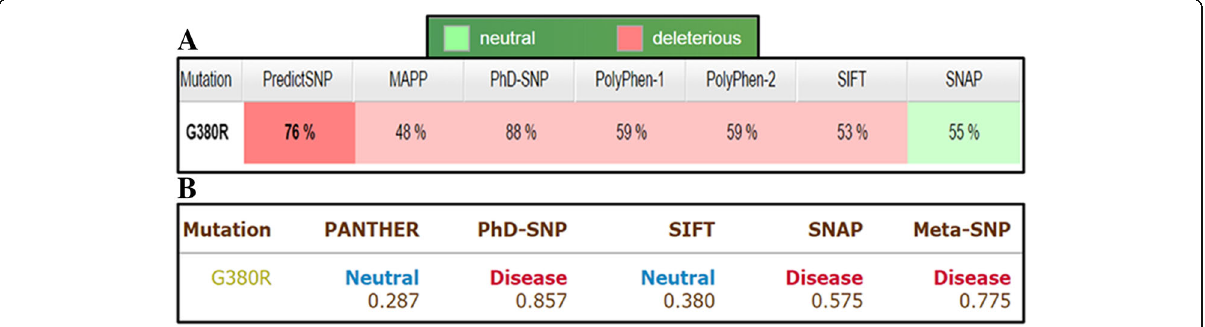
Fig. 4 FGFR3 Mutation (p.G380R) effect prediction: ( a ) PredictSNP results. b Meta SNP